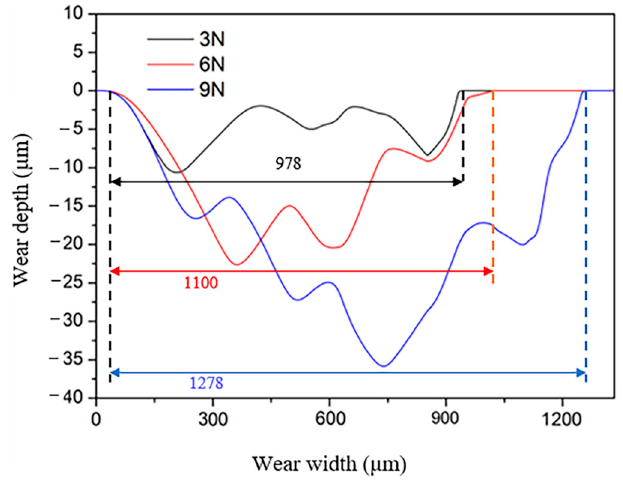
Figure 9. Wear cross-section trajectory curve of Ti-6Al-4V alloy under different load.